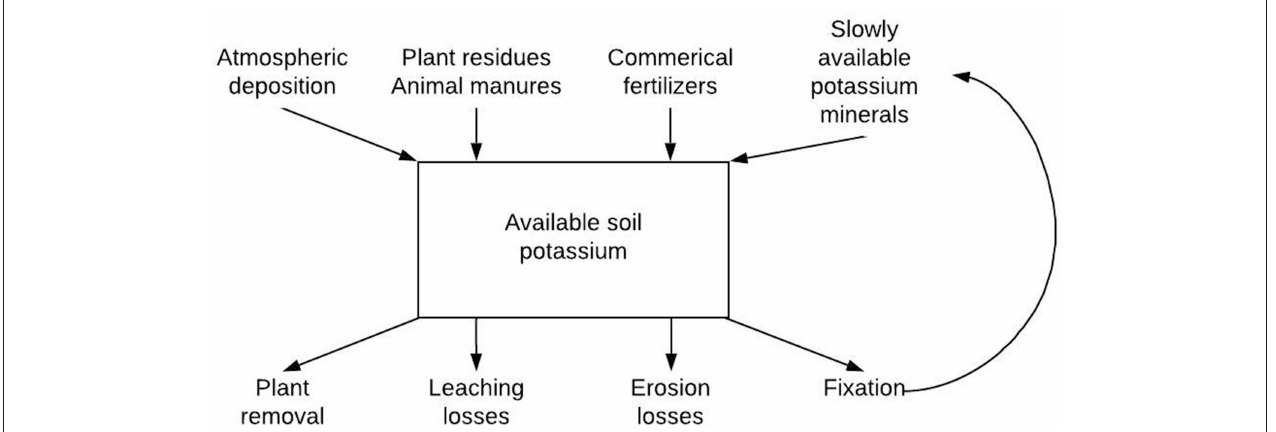
FIGURE 1 | The role of atmospheric potassium deposition in the gains and losses of available soil potassium under average field conditions (adapted from Brady and Weil, 2002).